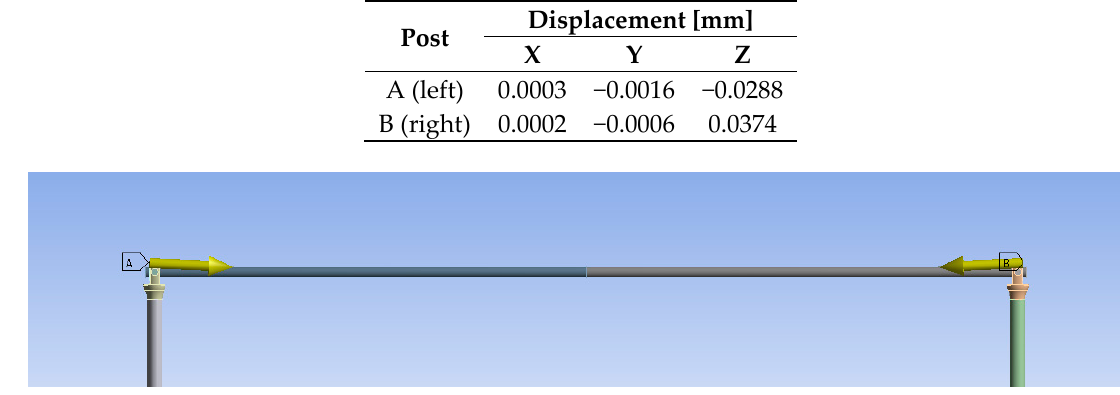
Figure 6. Analytical conditions.